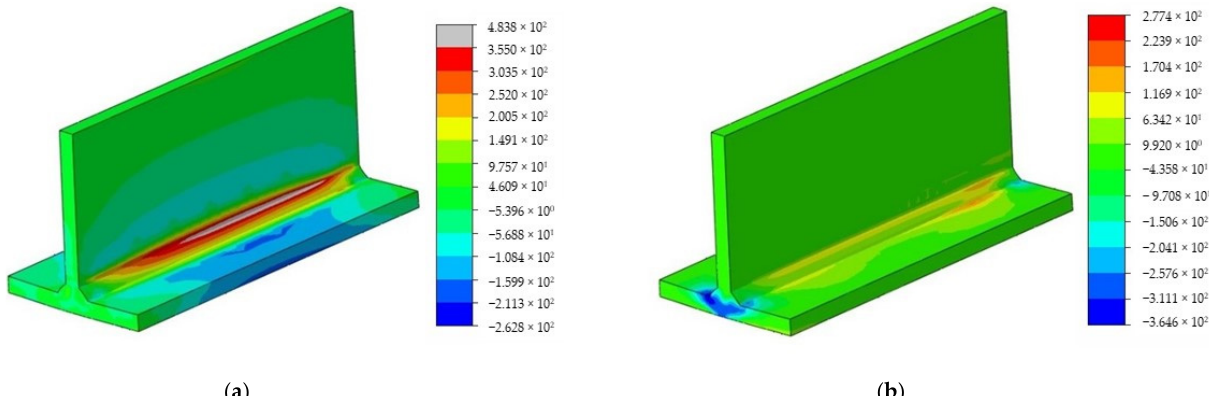
Figure 9. Numerically obtained full-field residual-stress distributions in the (unit: MPa): ( a ) longitudinal residual stress field; ( b ) transversal residual stress field.